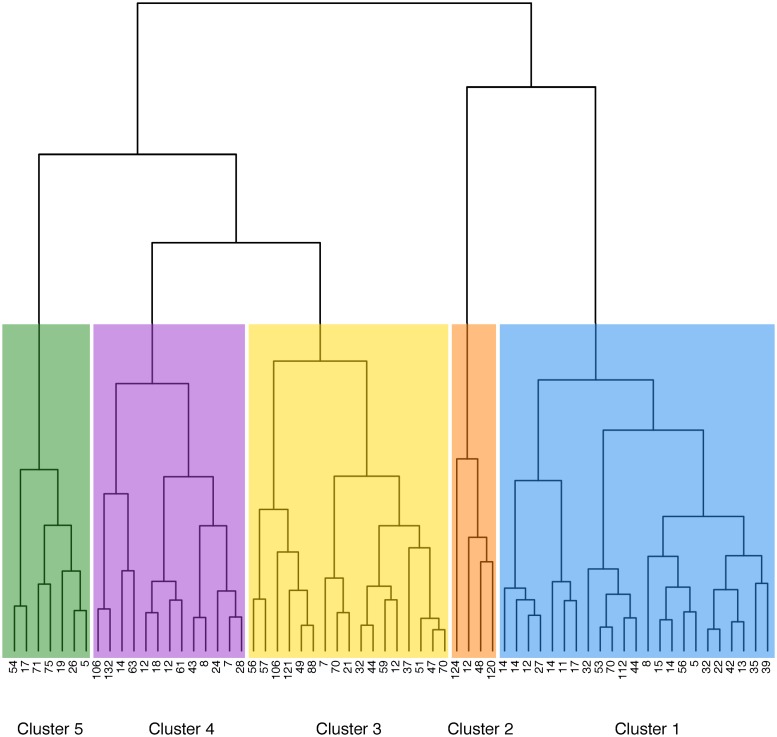
Dendrogram defining the clusters of centers.Each PD-center is represented by a black dot at the bottom of the dendrogram, with the number of catheter registered in it. In the virtual space of practices, distances between each center are computed. Centers are joined by nodes placed at a height that is proportional to the distance between the centers. Five clusters of centers are determined to optimize the variability between clusters while minimizing complexity.